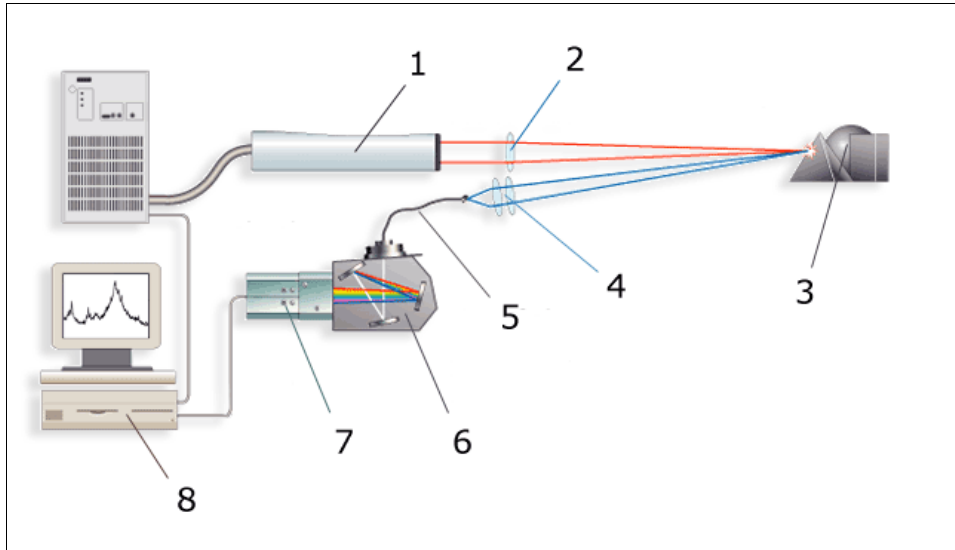
Figure 1. The LIBS experimental setup. 1 – Nd:YAG ablation laser, 2 – focusing